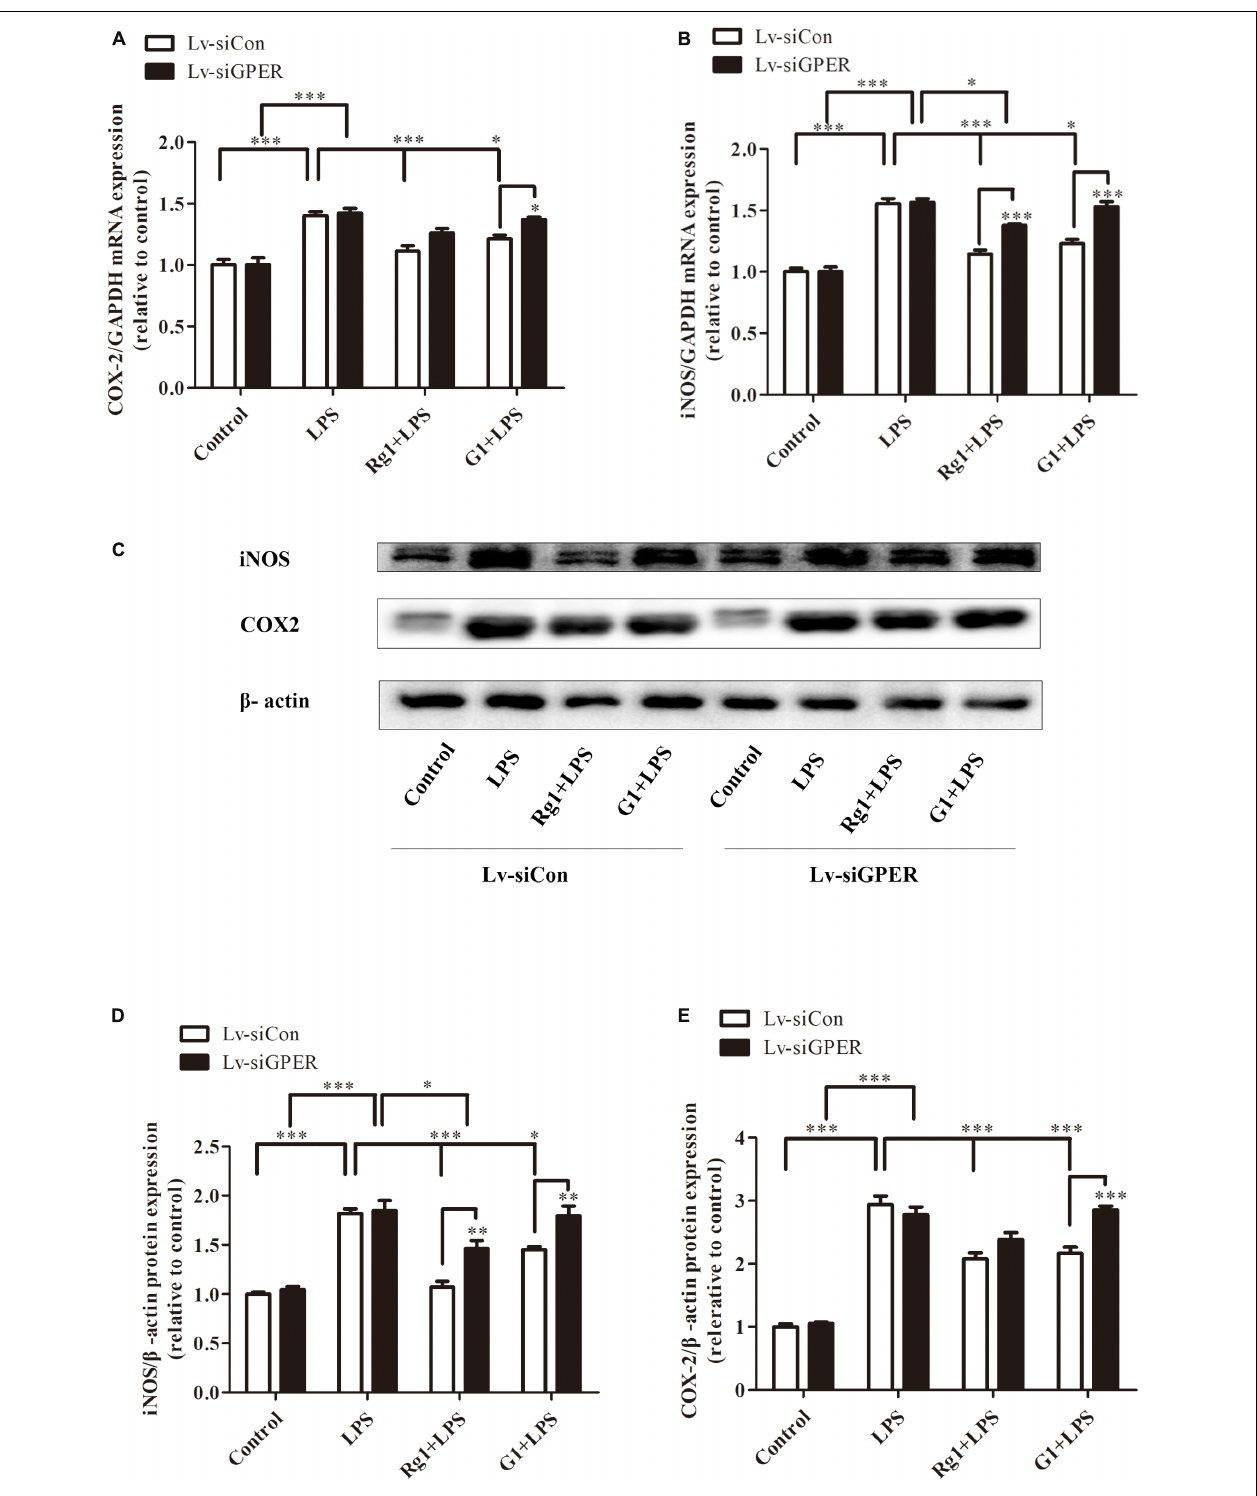
FIGURE 7 | G protein-coupled estrogen receptor gene silencing attenuated the anti-inflammatory effects of Rg1 on iNOS and COX-2 mRNA and protein expression in BV2 cells. BV2 cells were infected with Lv-siCon and LV-siGPER for 72 h separately, followed by 1 µ g ml − 1 LPS for 24 h. Total RNA and cell lysates were prepared to detect the iNOS and COX-2 mRNA and protein levels. COX-2 (A) and iNOS (B) mRNA levels were measured using quantitative real-time PCR. GAPDH was used as an internal control. Western blot (C) was used to detect protein expression of iNOS (D) and COX-2 (E) . β -Actin was used as an internal control. Results are expressed as the mean ± SEM, n = 3–5. ∗ P < 0.05, ∗∗ P < 0.01, and ∗∗∗ P < 0.001 by a two-way ANOVA followed by post hoc Bonferroni/Dunn test.